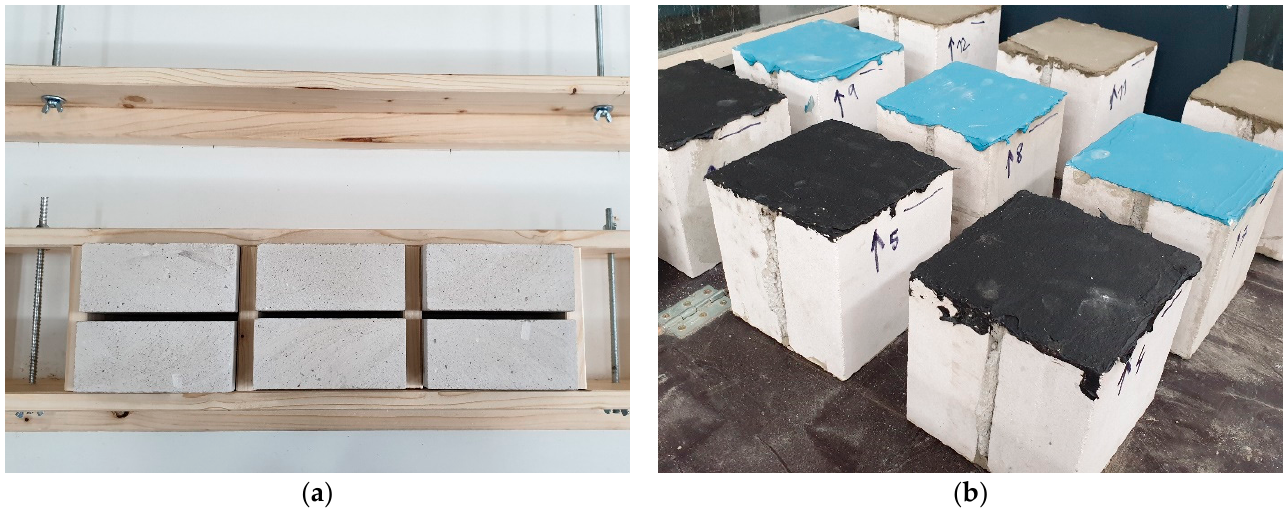
Figure 3. ( a ) Test specimen—lime-sand bricks and lime-cement mortal in wooden formwork; ( b ) test specimens with applied waterproof screeds.